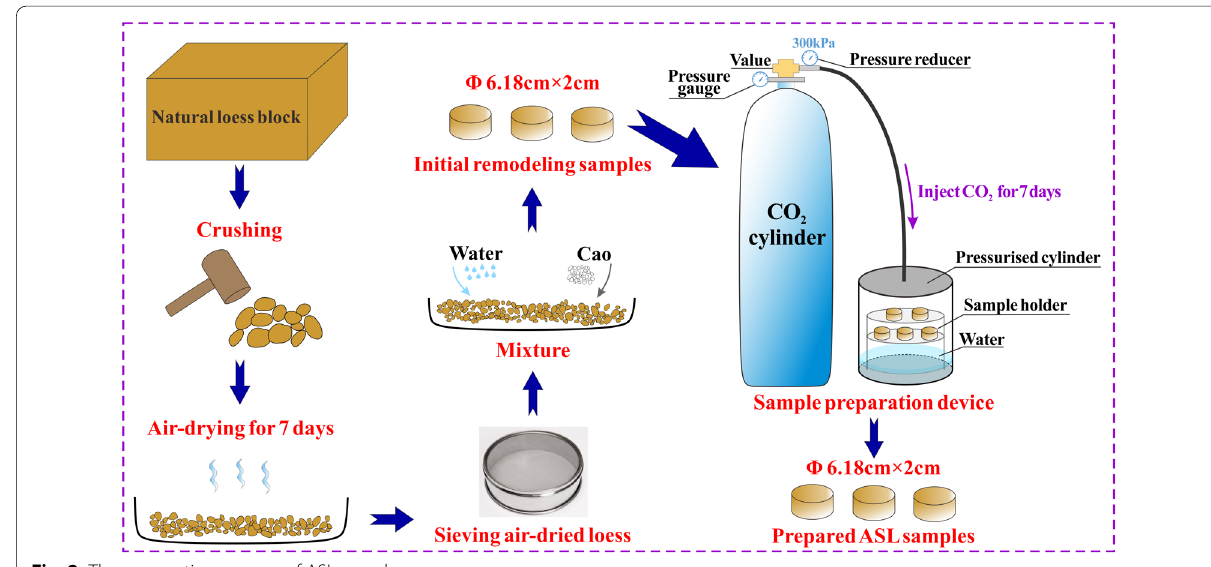
Fig. 2 The preparation process of ASL